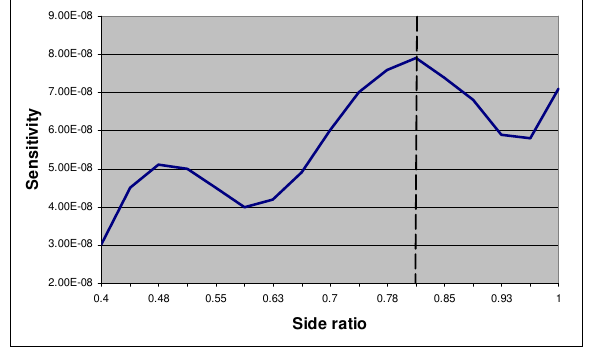
Fig 3. Approximated values of sensitivity of in-plane Poisson’s ratio to the side ratio